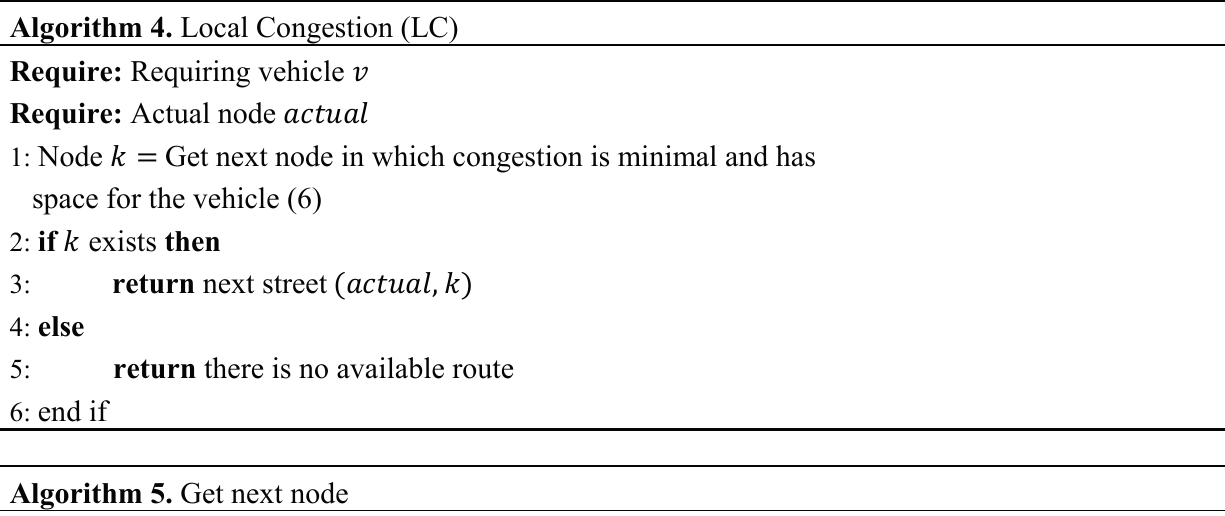
Algorithm 4. Local Congestion (LC)